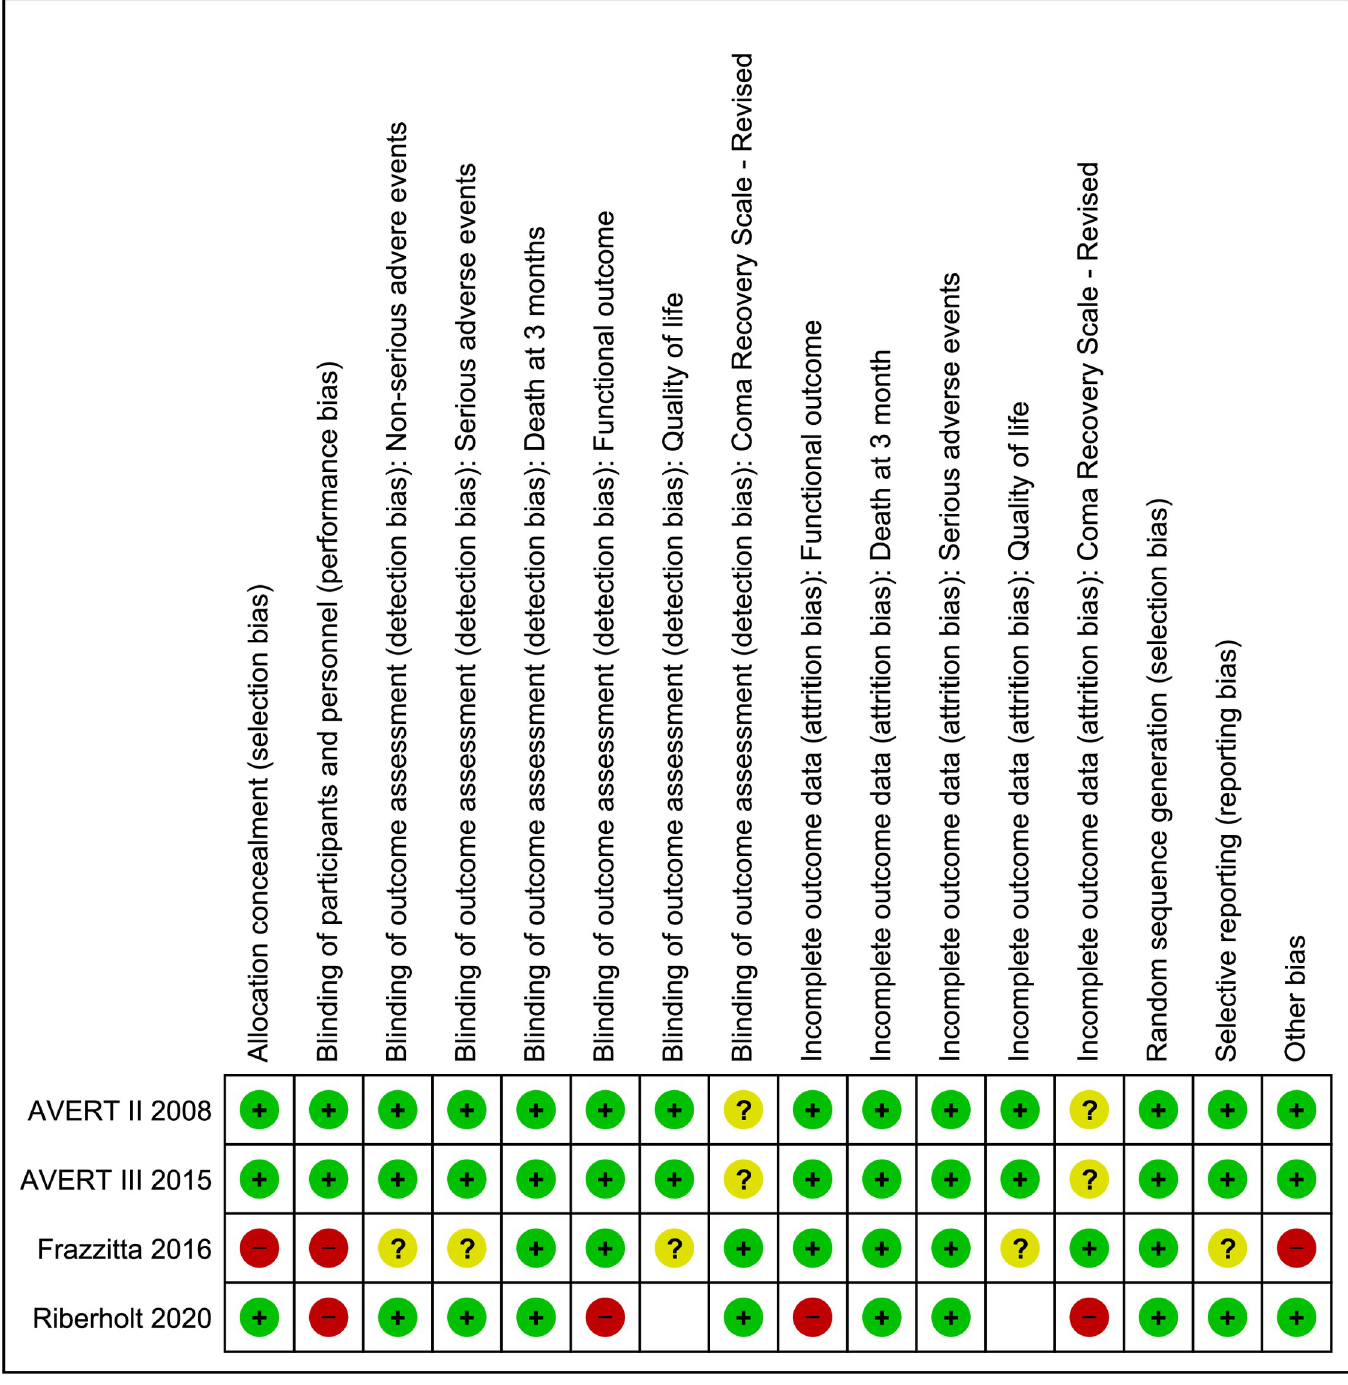
Fig 2. Risk of bias assessment: Review authors’ judgements about each risk of bias item for each included study.